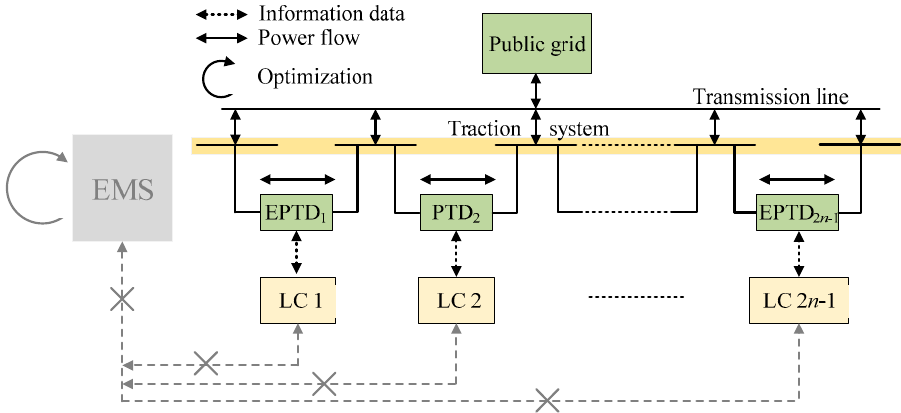
Figure 4. Failure of the centralized control.